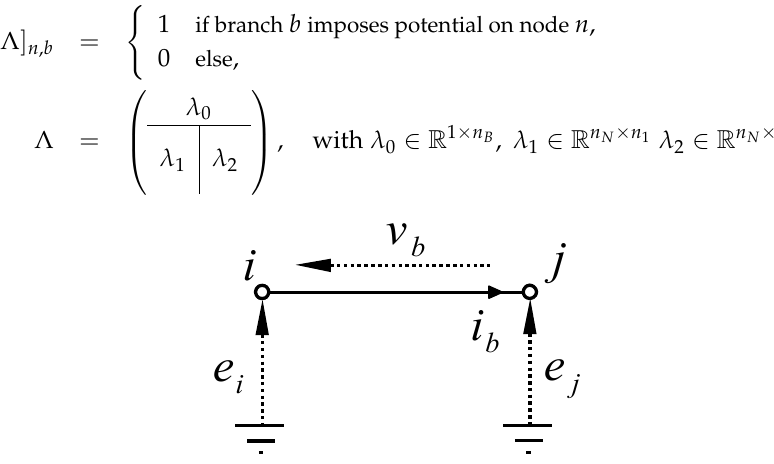
Figure 3. Definitions and orientations for a single current-controlled edge b from node i to node j , with nodes potentials e i and e j , respectively. The knowledge of the potential e j is transferred to node i with e i = v b + e j